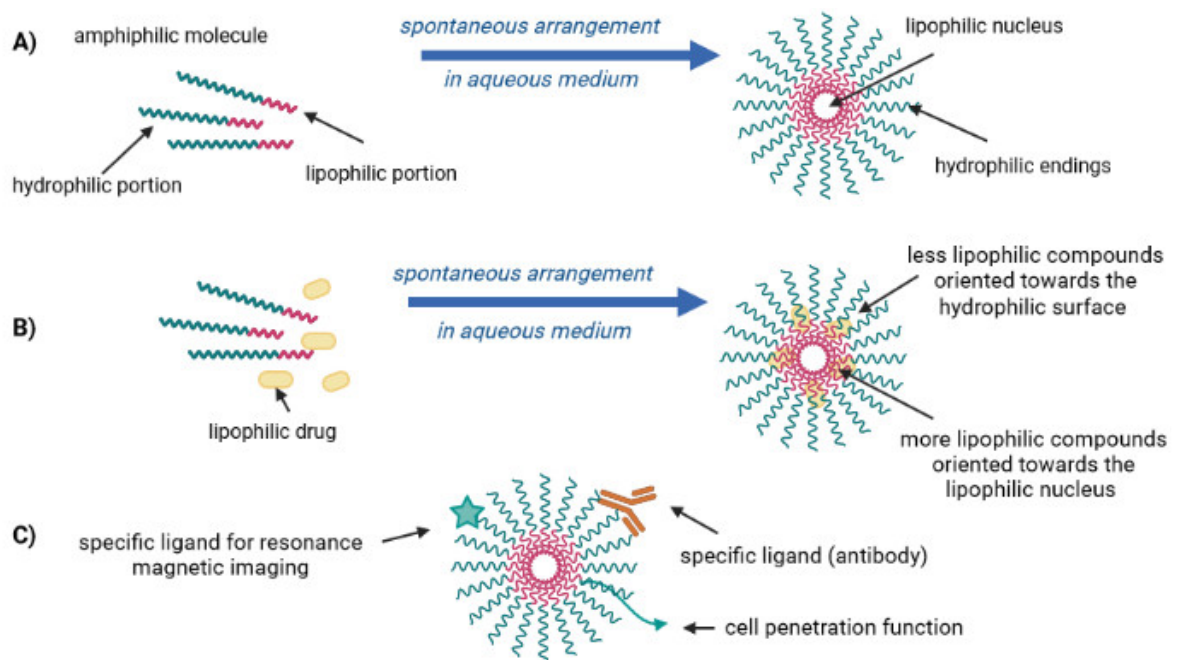
Figure 6. Schematic representation of pharmaceutical micelles [own drawing]. ( A ) spontaneous formation of a micelle, of an amphiphilic molecule in an aqueous medium; ( B ) incorporation of lipophilic drugs into a micelle; ( C ) multifunctional pharmaceutical micelles [own drawing].